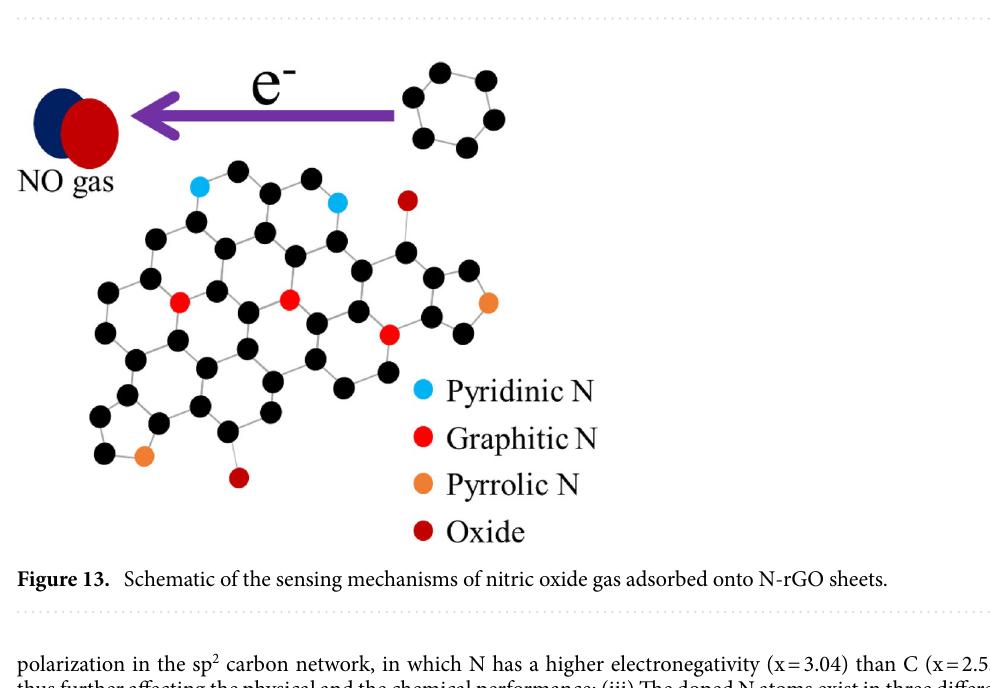
Figure 12. Long-term stability of gas sensor.